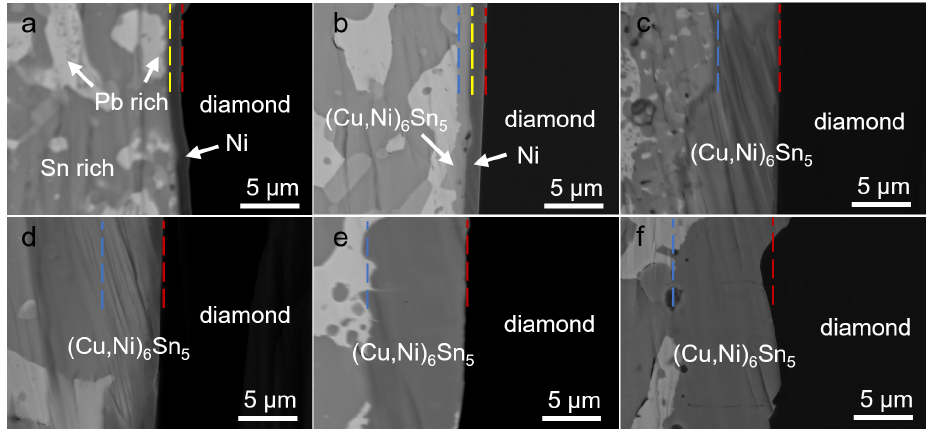
Figure 10. Cross ‐ section SEM images of the solder–resistor interface under the aging of ( a ) 0 day, ( b ) 4 days, ( c ) 16 days, ( d ) 25 days, ( e ) 36 days, ( f ) 49 days. ( b ) 4 days, ( c ) 16 days, ( d ) 25 days, ( e ) 36 days, ( f ) 49